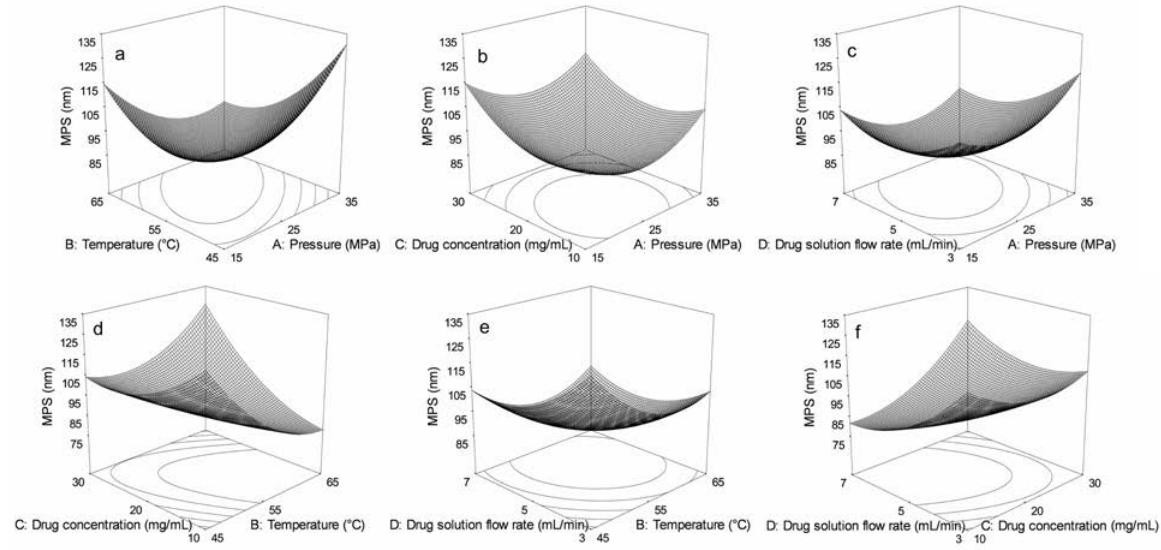
Figure 1. Optimization of preparation of GTW nanoparticles using BBD. ( a ) Interaction of precipitation pressure and temperature; ( b ) Interaction of precipitation pressure and drug concentration; ( c ) Interaction of precipitation pressure and drug solution flow rate; ( d ) Interaction of precipitation temperature and drug concentration; ( e ) Interaction of precipitation temperature and drug solution flow rate; ( f ) Interaction of drug concentration and drug solution flow